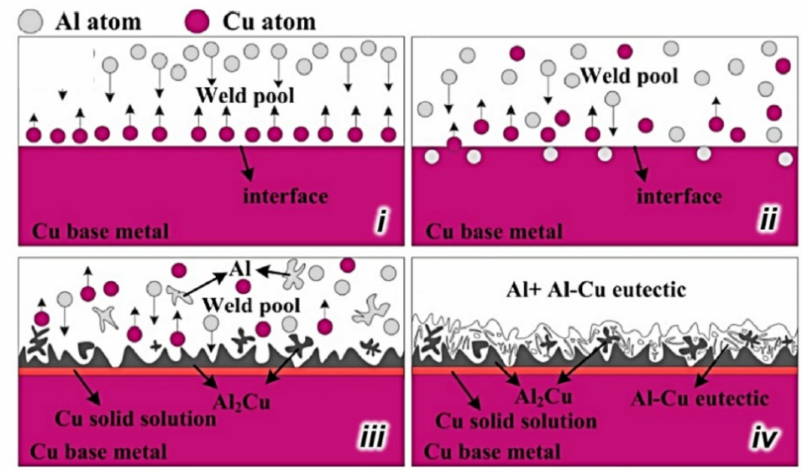
Figure 20. IMC layer formation and growth in lap joint between Al and Cu. From